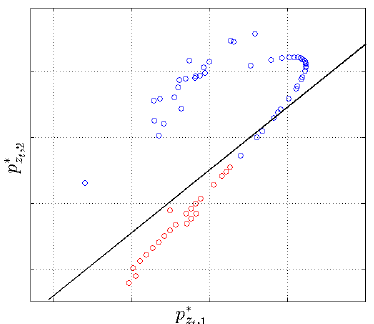
Figure 7. Visualising the switching AR posterior state probabilities for data from a single walking test. The log of the input state probabilities p z analysis (LDA), and projections are denoted with p ∗ z